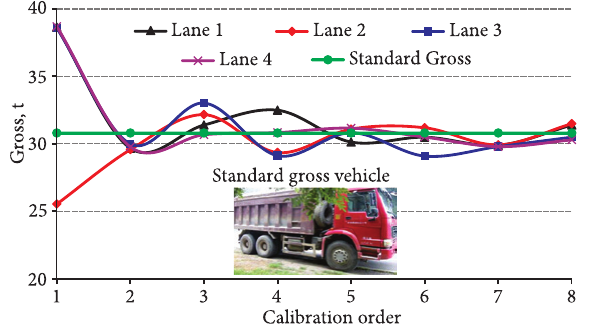
Fig. 2. Installation of WIM system